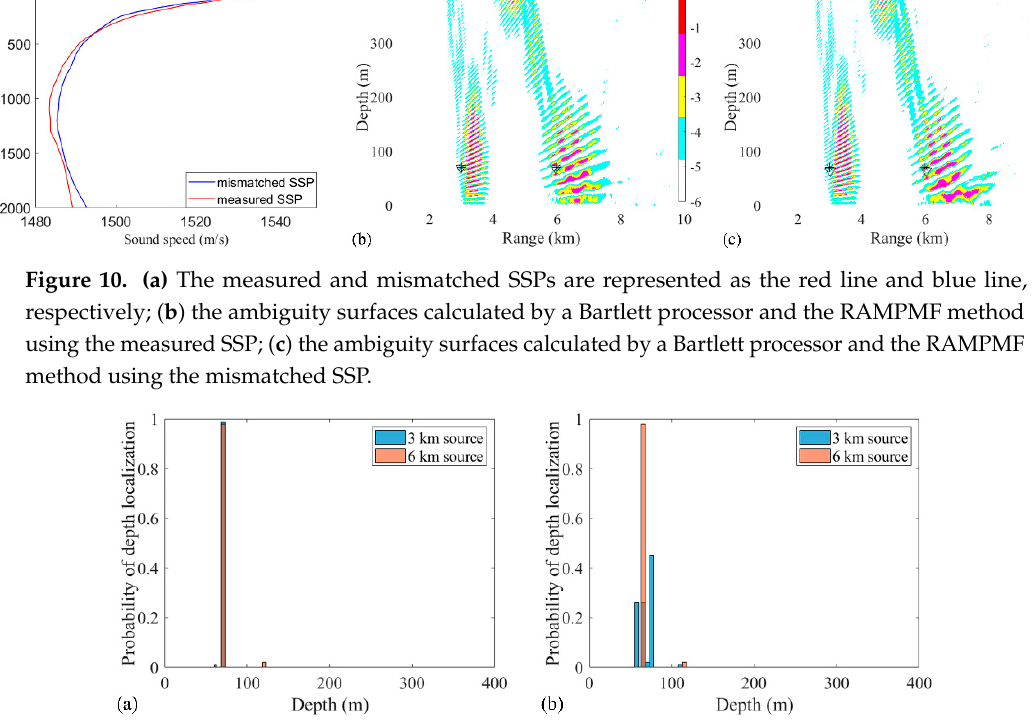
Figure 11. The probabilities of depth estimation within 500 realizations using ( a ) the measured SSP and ( b ) the mismatched SSP.